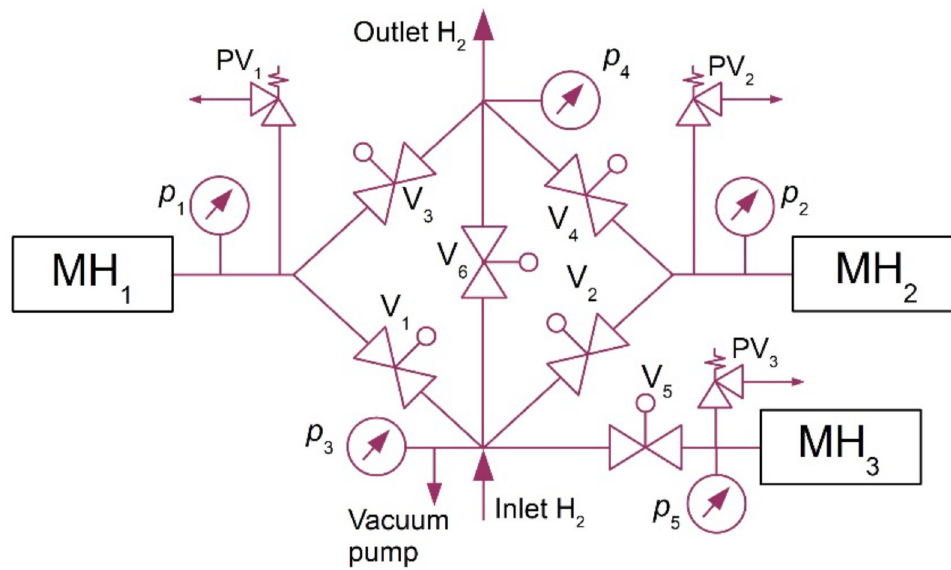
Figure 2. Hydrogen circuit